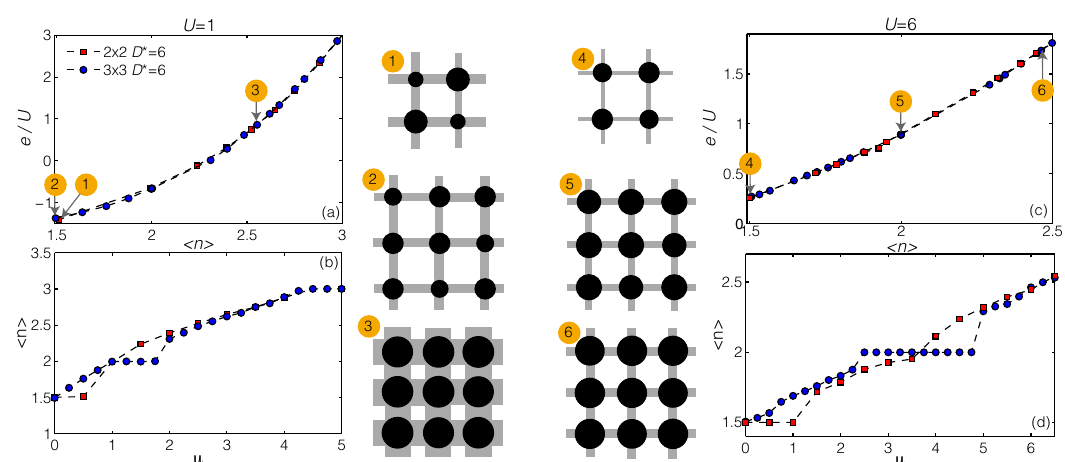
Figure 11: Non-abelian iPEPS results for the three-flavor Hubbard model for U = 1 (left panels) and U = 6 (right panels). Panels (a) and (c) display the ground-state / U as a function of filling 〈 n 〉 for iPEPS simulations on a 2 × 2 and 3 × 3 unit energy e 0 cell, whereas (b) and (d) show the filling 〈 n 〉 as a function of the chemical potential µ . Panels (1) to (6) depict individual iPEPS wavefunctions at the points marked in panels (a,c). The filling per site and the bond energy are proportional to the diameter of the black dots and the width of the bonds, respectively. Table 2: Typical multiplet configurations on the auxiliary bonds obtained from SU(3) symmetric iPEPS simulations on the square lattice Hubbard model with three equiv- alent flavors. The different rows show the results for increasing multiplet bond di- mension D ∗ (left column) at half filling. The SU ( 3 ) multiplet labels are in Dynkin form, where we adopt the compact QSpace [ 30 ] notation. For the center column we use the same notation as in Table